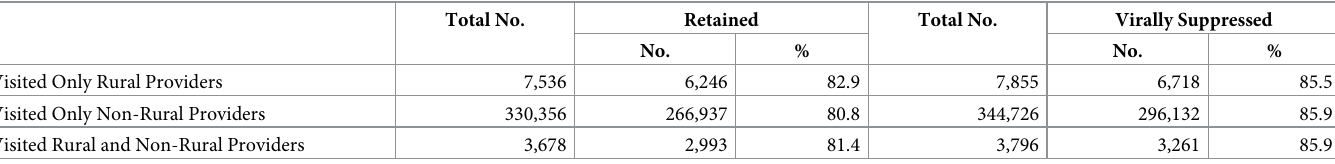
Table 5. Retention in care and viral suppression among RWHAP clients, 2017.